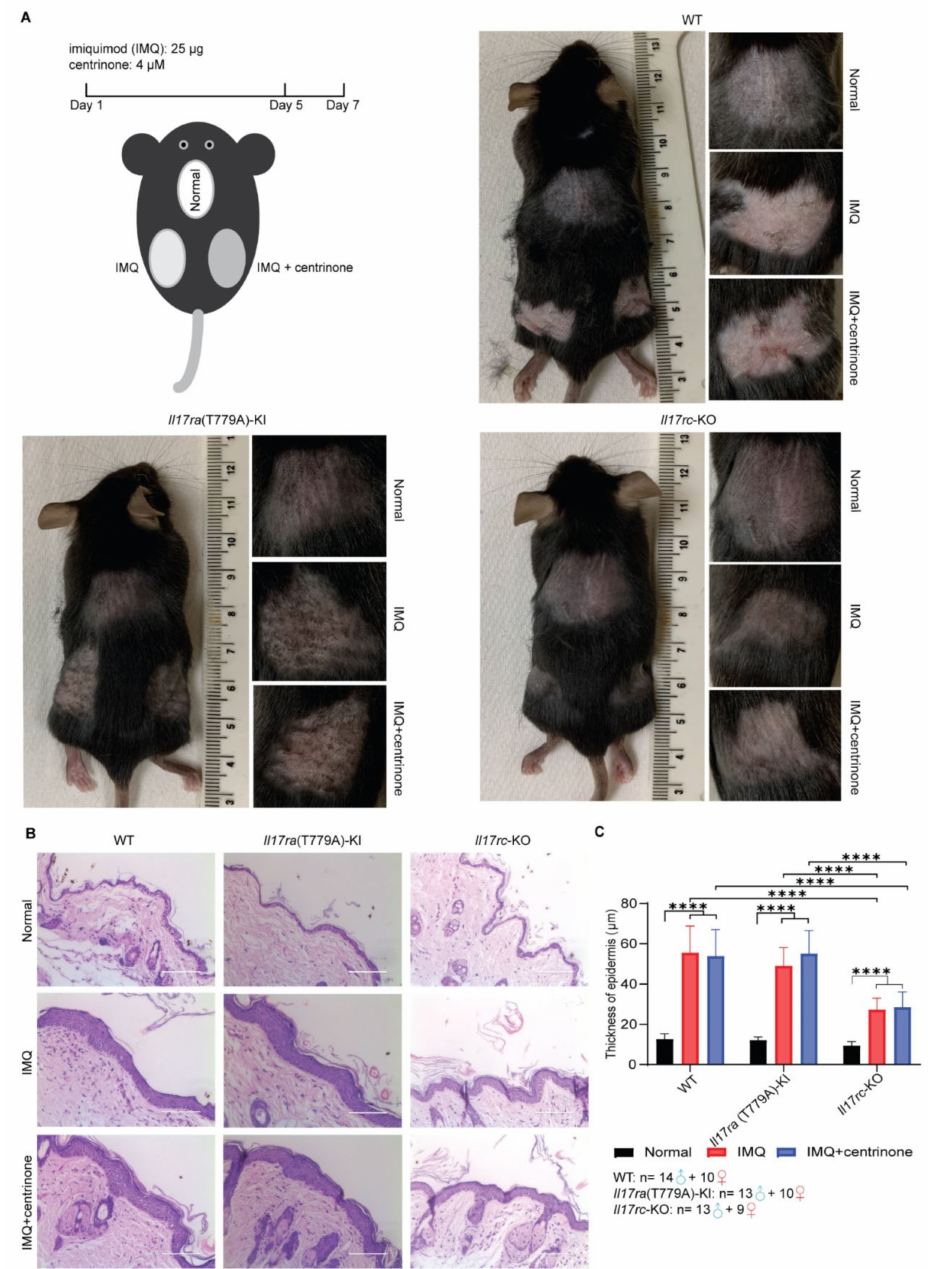
Figure 3. Knockout of Il17rc alleviates skin lesions induced by imiquimod. ( A ) Diagram of establish- ing the imiquimod-induced psoriasis mouse model and skin lesions of WT C57BL/6J, Il17ra (T779A)- knockin, and Il17rc -knockout strains. ( B ) Representatives of hematoxylin and eosin stain of skin lesions. Scale bar represents 100 µ m. ( C ) To analyze the statistical significance of the thickness of epidermis, a two-tailed Student’s t test was applied. Error bar represents mean ± SD. **** indicates p < 0.0001. The numbers of male and female mice in each group are indicated in the